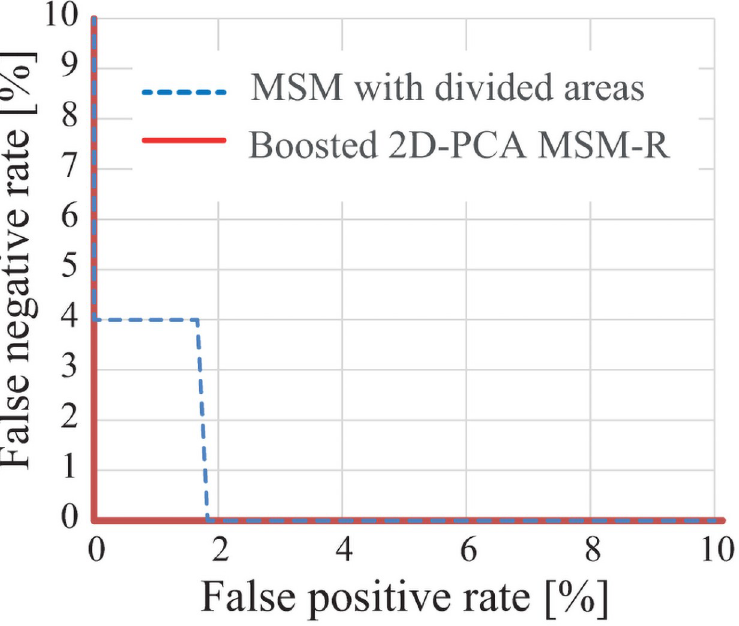
Fig 15. ROC curves of the MSM-based method with divided areas [12] and the B-2D-PCA-R MSM. Gallery speed and probe speed are 3 km/h and 7 km/h,